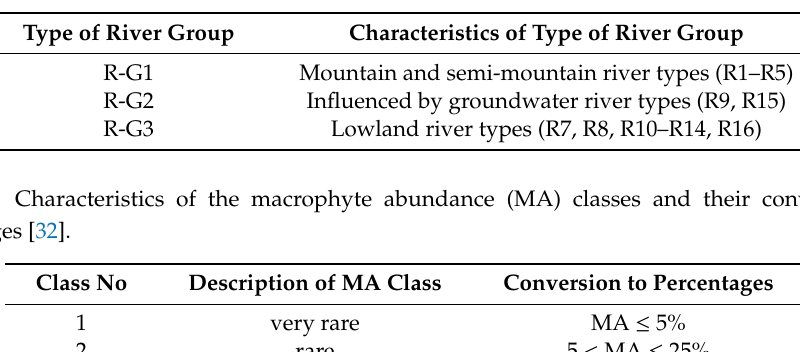
Table 2. Division into river types according to the RI-BG method [34].